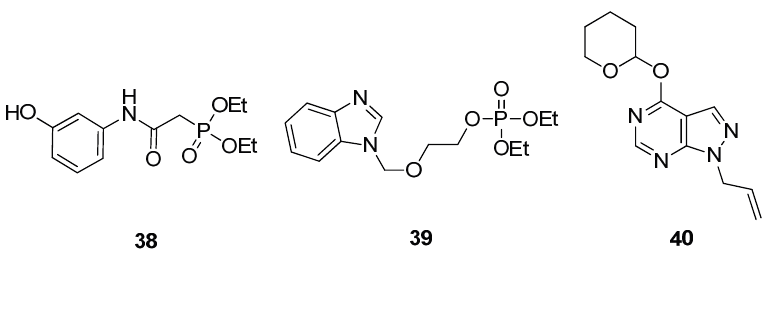
Figure 12. Structure of three classes of potential Mt GS